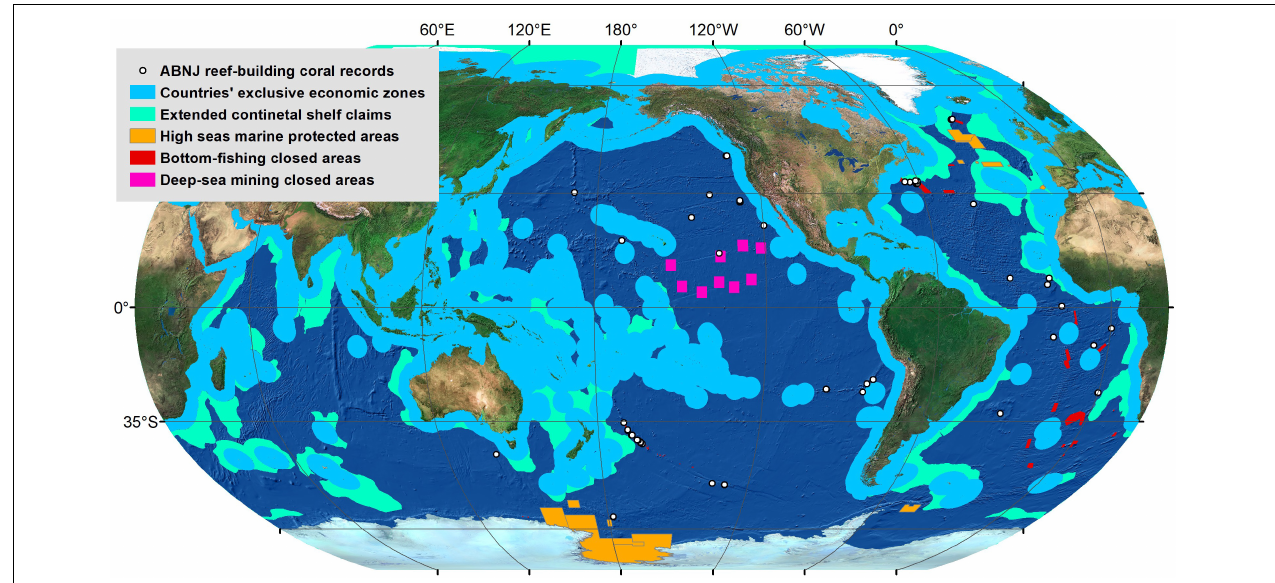
FIGURE 1 | Spatial distribution of the reef-building coral records in marine areas beyond national jurisdiction (ABNJ) examined as part of this study, along with areas where human activities are regulated on the high seas, including marine protected areas (MPAs), areas closed to bottom fishing, and areas closed to deep-sea mining activities. Of the 116 reef-building coral records in ABNJ, none were located in MPAs, with another 25 in bottom-fishing closed areas, and one in areas that are closed to mining